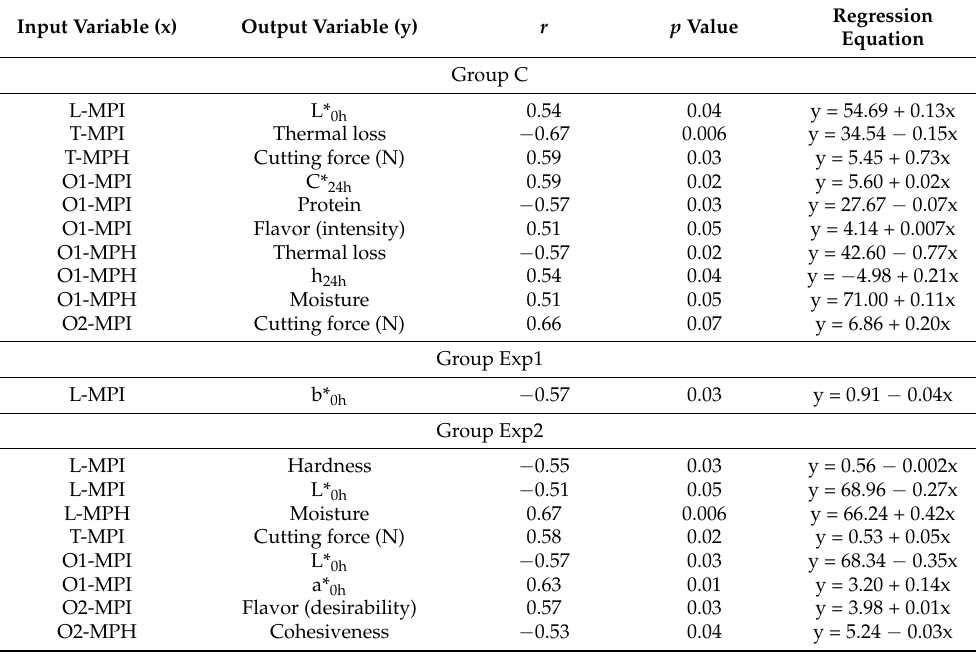
Table 7. Summary of significant correlations among echotextural variables and sen- sory/physicochemical properties of pectoralis major muscles recorded in organic turkeys allotted to three different nutritional